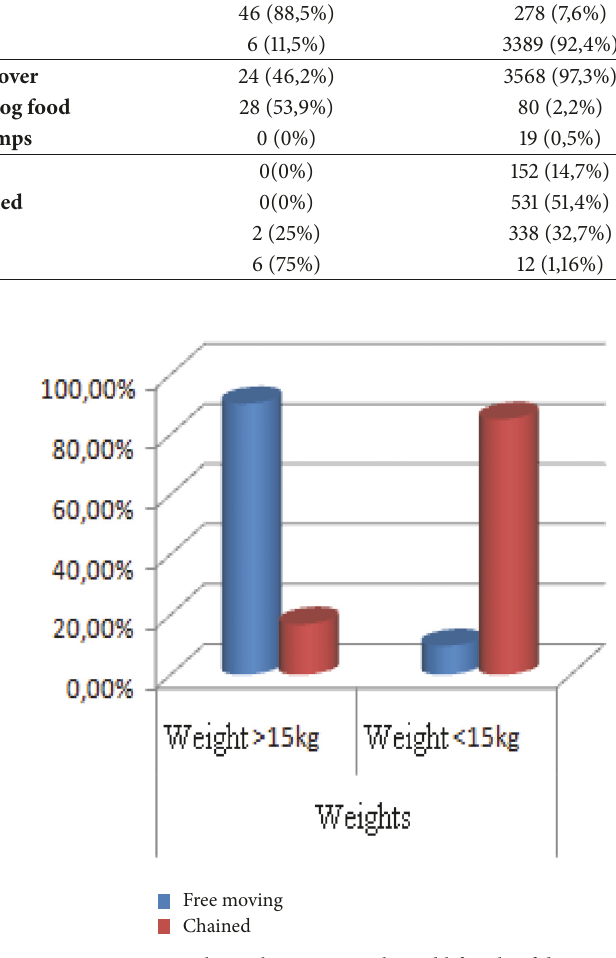
Figure 5: Correlation between weight and lifestyle of dogs.